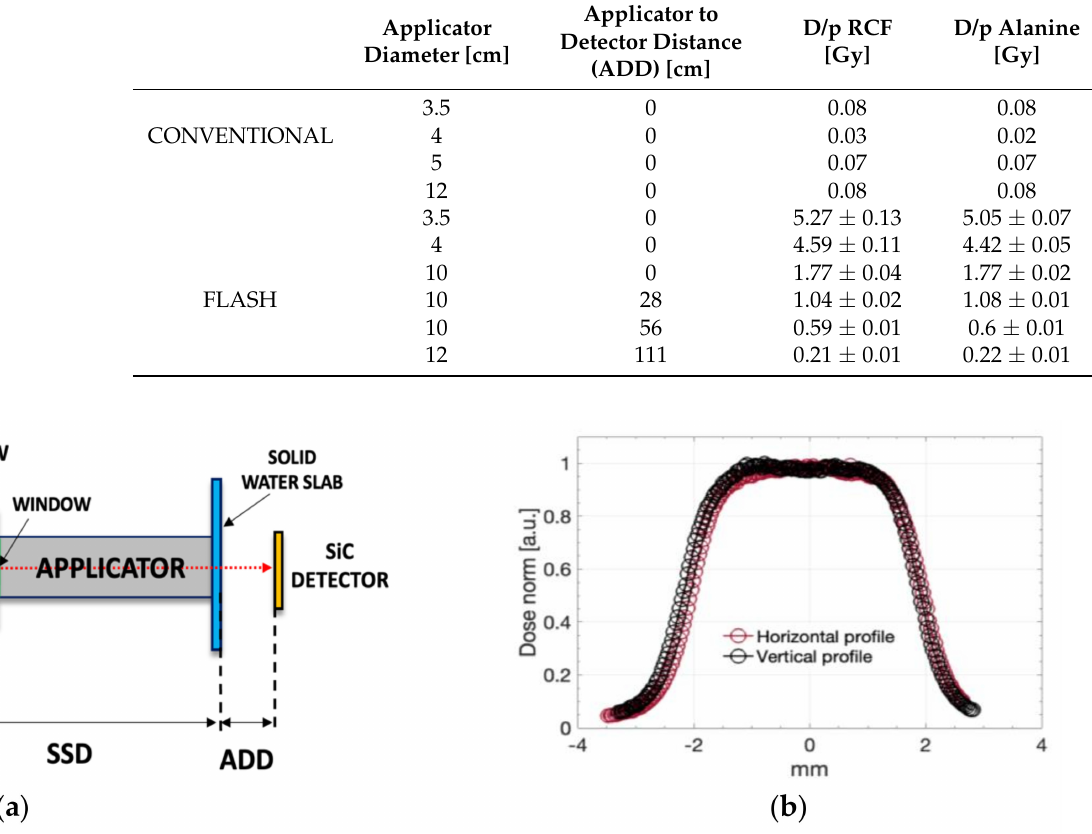
Figure 4. ( a ) Sketch of the experimental setup indicating the source to distance surface (SSD) and the applicator to detector distance (ADD) that is reported in Table 2. ( b ) Dose transversal profiles measured with an RCF-EBT3